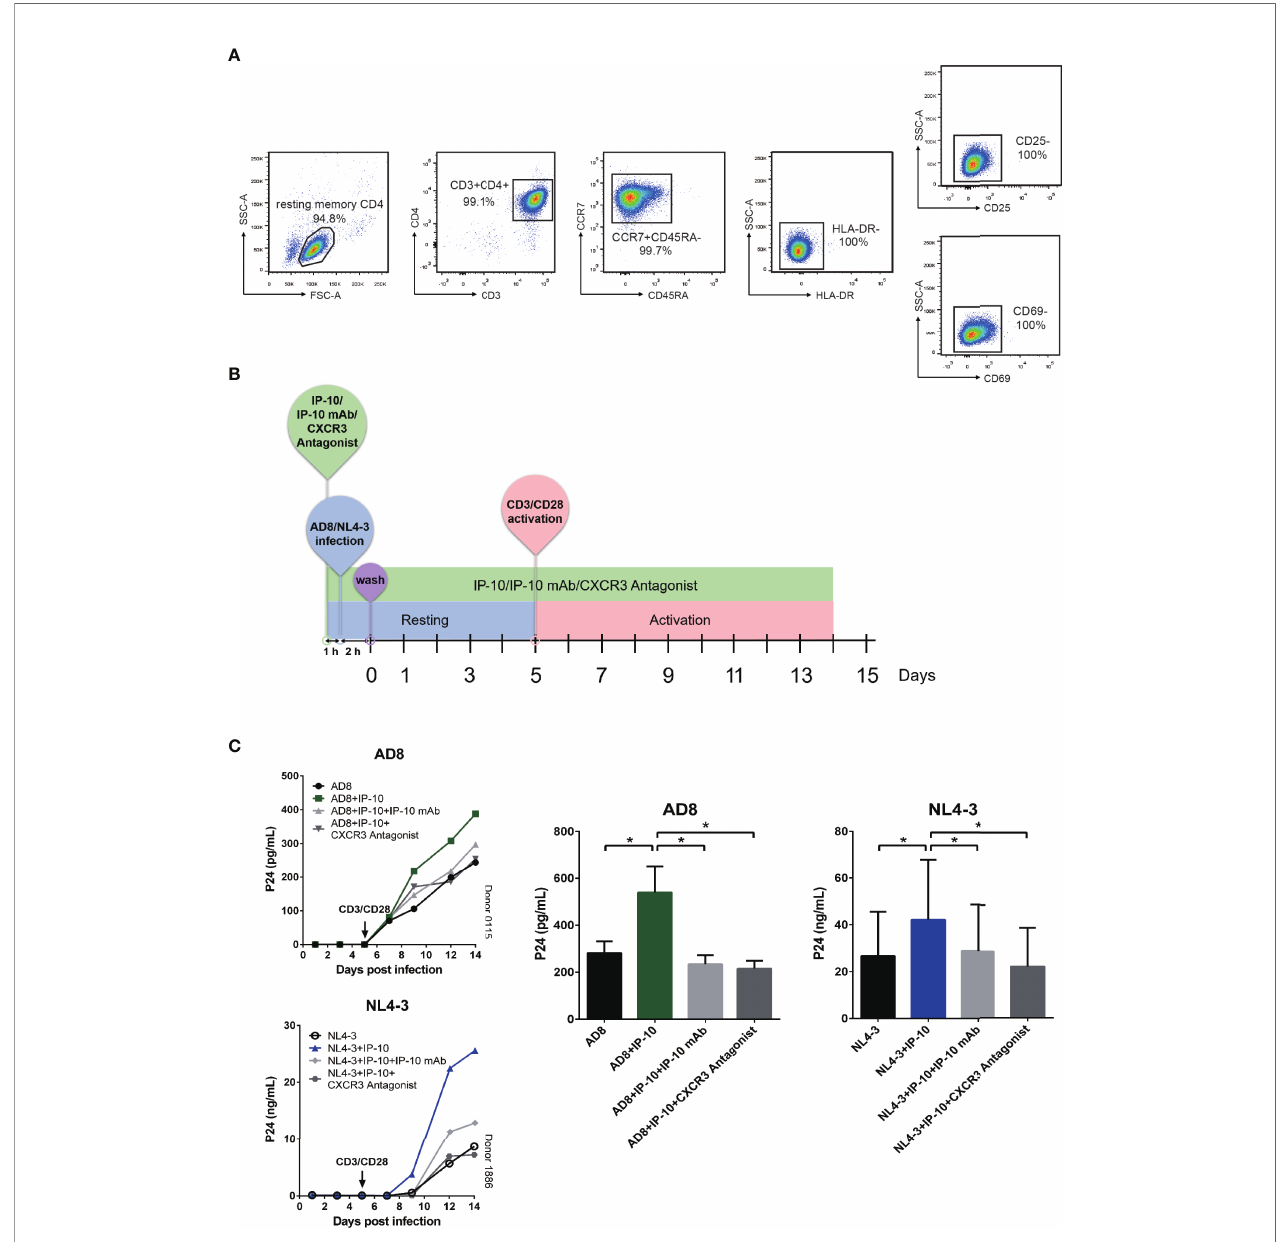
FIGURE 2 | IP-10 promotes HIV AD8 and NL4-3 infection of resting memory CD4 + T cells. (A) Gating strategy for isolating a pure population of resting memory CD4 + T cells. (B) Schematic illustration of the procedure for evaluating the role of IP-10 in HIV infection of resting memory CD4 + T cells. (C) Kinetics of the effect of AD8 (n = 6)/NL4-3(n = 11), AD8/NL4-3+IP-10, AD8/NL4-3+IP-10+mAb, and AD8/NL4-3+IP-10+CXCR3 on resting memory CD4 + T cell from 2 representative NCs. P24 levels were compared between groups on the 14 th day post infection by one-way analysis of variance. * P <